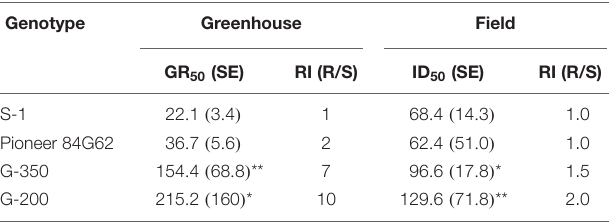
TABLE 1 | Regression parameters describing the response of sorghum genotypes to tembotrione under greenhouse and field conditions.